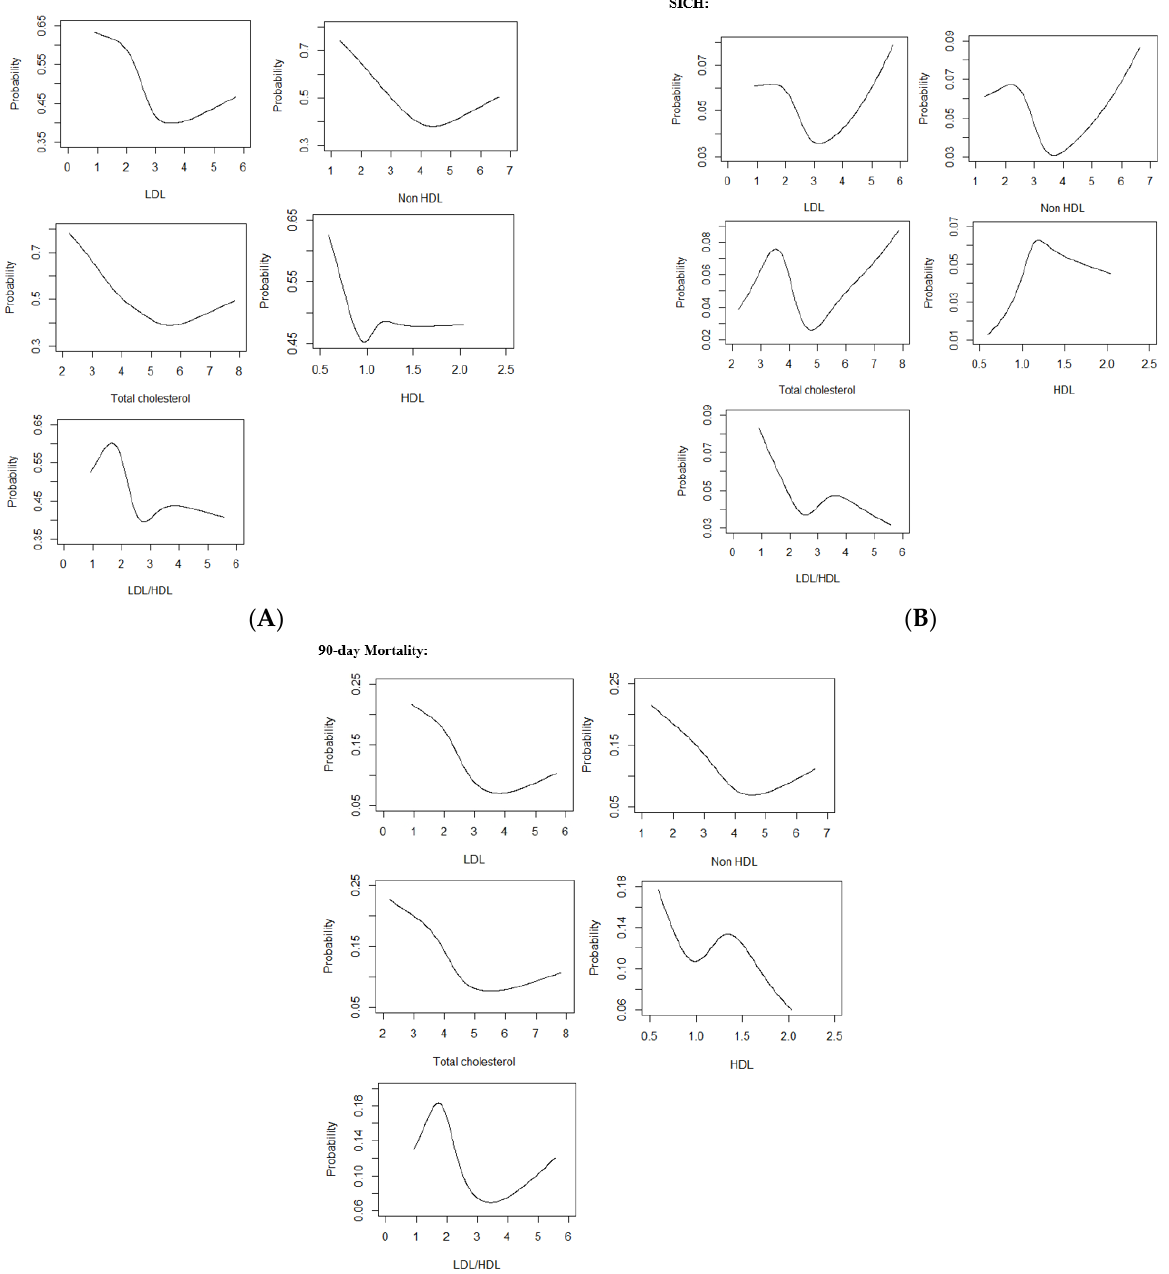
Figure 2. ( A ) Restricted Cubic Spline Curves relating Lipid Parameters with Poor Functional Outcome ( B ) Restricted Cubic Spline Curves relating Lipid Parameters with SICH ( C ) Restricted Cubic Spline Curves relating Lipid Parameters with Mortality.Abbreviations: LDL low-density lipoprotein cholesterol, HDL high-density lipoprotein cholesterol, LDL/HDL low-density lipoprotein cholesterol/high-density lipoprotein cholesterol ratio, SICH symptomatic intracranial hemorrhage.